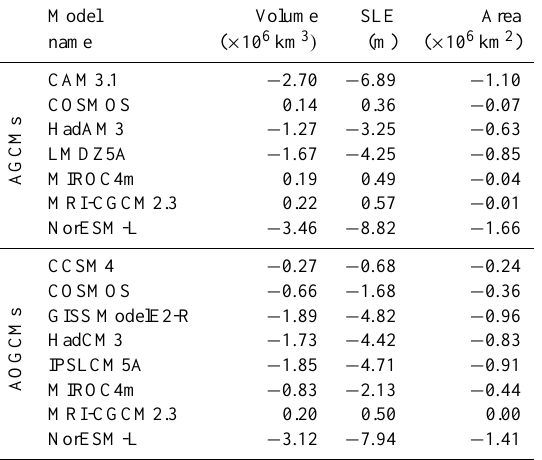
Table 4. GrIS diagnostics for the PlioMIP simulations, including volume, sea level equivalent (SLE) and ice area using the stan- dard BASISM parameters. Values are given as a difference from the simulated pre-industrial GrIS, when the same GCM pre-industrial forcing climatology is used. For example, negative volume or area means that the GrIS reduces in size compared to the GCM pre- industrial control. All simulated volumes (for each parameter set) can be found in the Supplement (Table